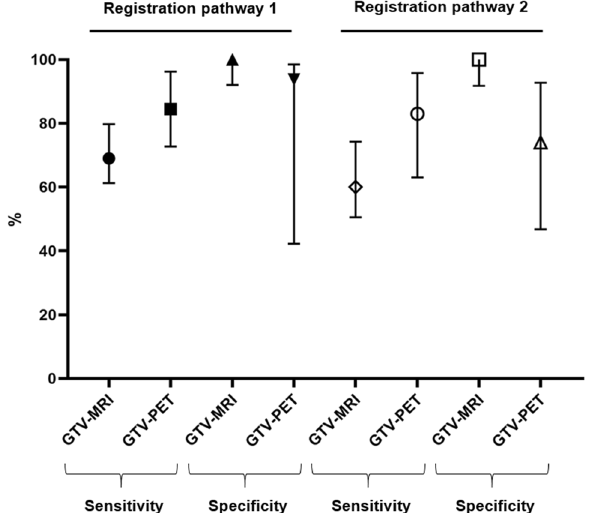
Figure 5. Sensitivity and specificity for mpMRI and PSMA-PET. Displayed are sensitivity and specificity for mpMRI (GTV-MRI) and [ 18 F]PSMA-1007 PET (GTV-PET) for registration pathway 1 and 2. The median values and interquartile ranges over all patients are